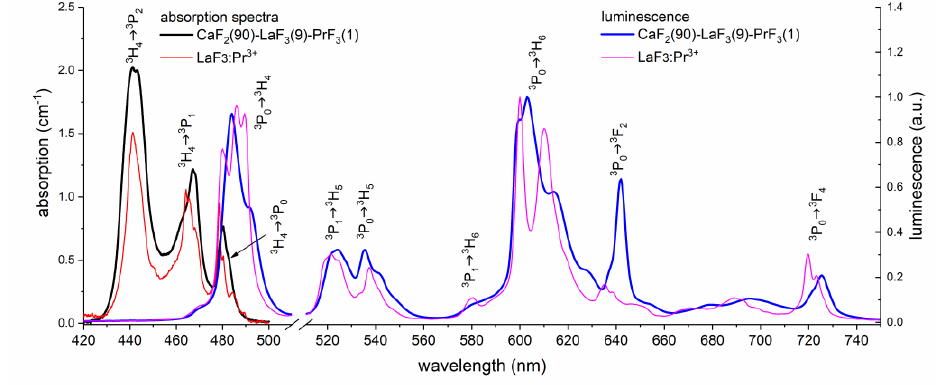
Fig. 1. Absorption and luminescence spectra of CaF 2 (90)-LaF 3 (9)-PrF 3 (x=1) and LaF 3 :Pr 3+ (C pr =1